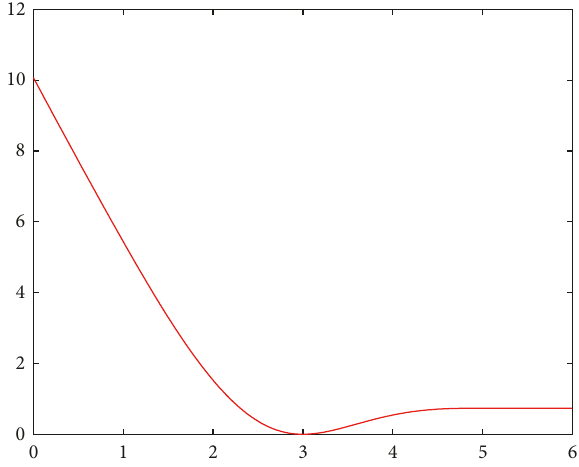
Figure 1: Shape of the bounded potential function 𝜓(𝑧)